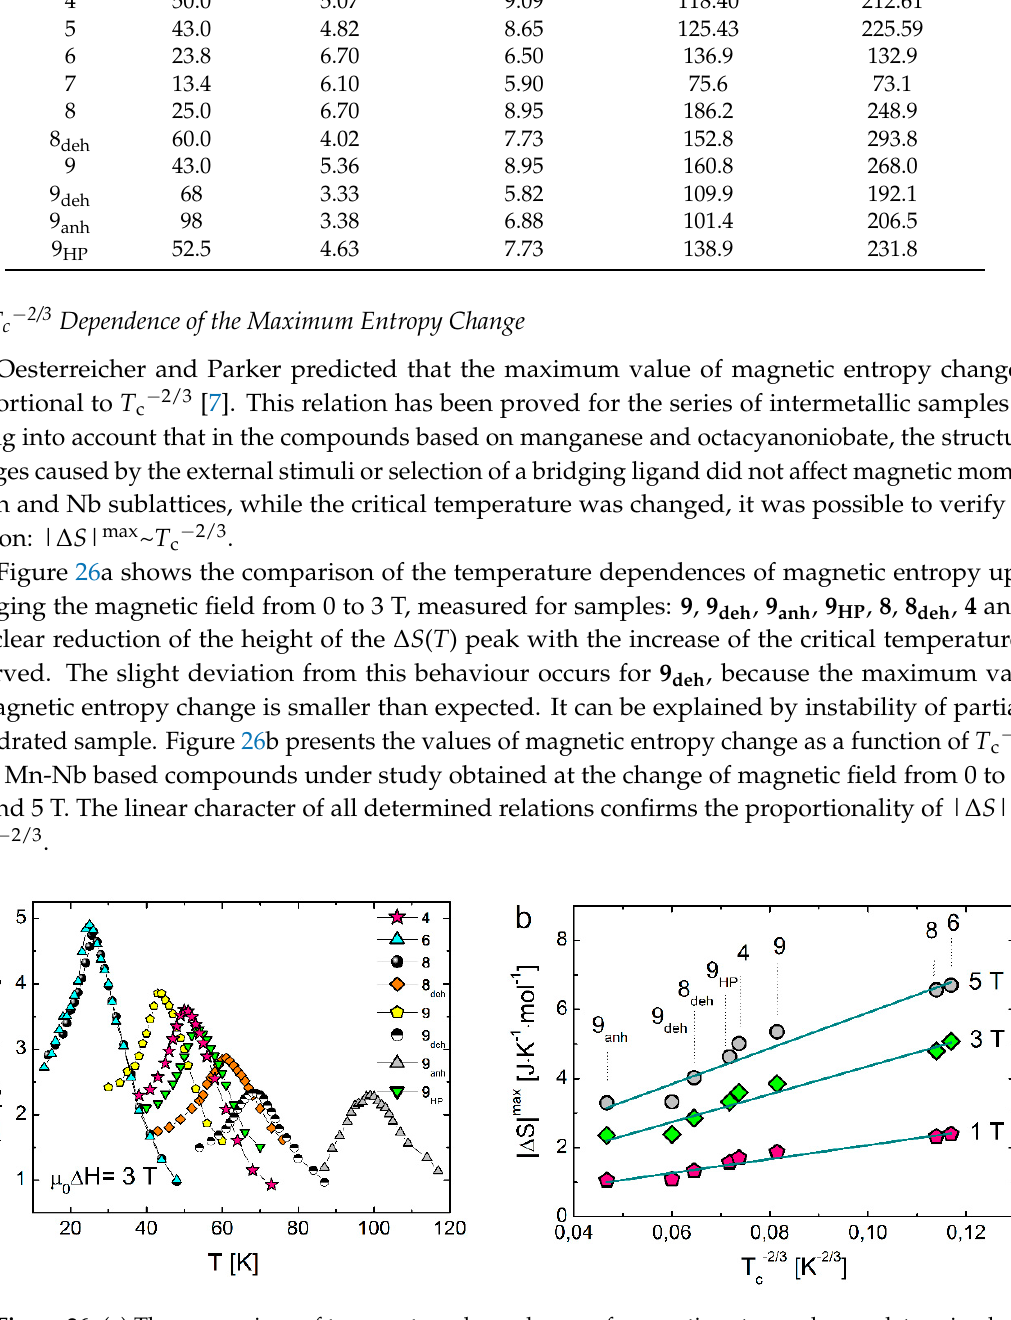
Figure 26. ( a ) The comparison of temperature dependences of magnetic entropy change determined for the manganese octacyanoniobate-based samples with different ligands: pyridazine for samples 9 , 9 deh , 9 anh , and 9 HP , imidazole for 8 and 8 deh ,pyrazole for 4 and ligand-free 6 . ( b ) The maximum values of magnetic entropy change | ∆ S | max obtained for 9 , 9 deh , 9 anh , 9 HP , 8 , 8 deh , 4 , and 6 at the change of magnetic field µ 0 ∆ H = 1, 3 and 5 T as a function of T c − 2/3